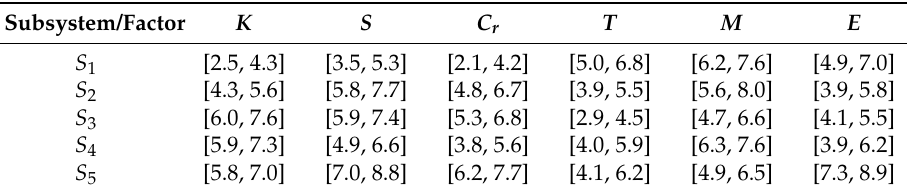
Table 4. Interval expert evaluation for subsystems about six factors.